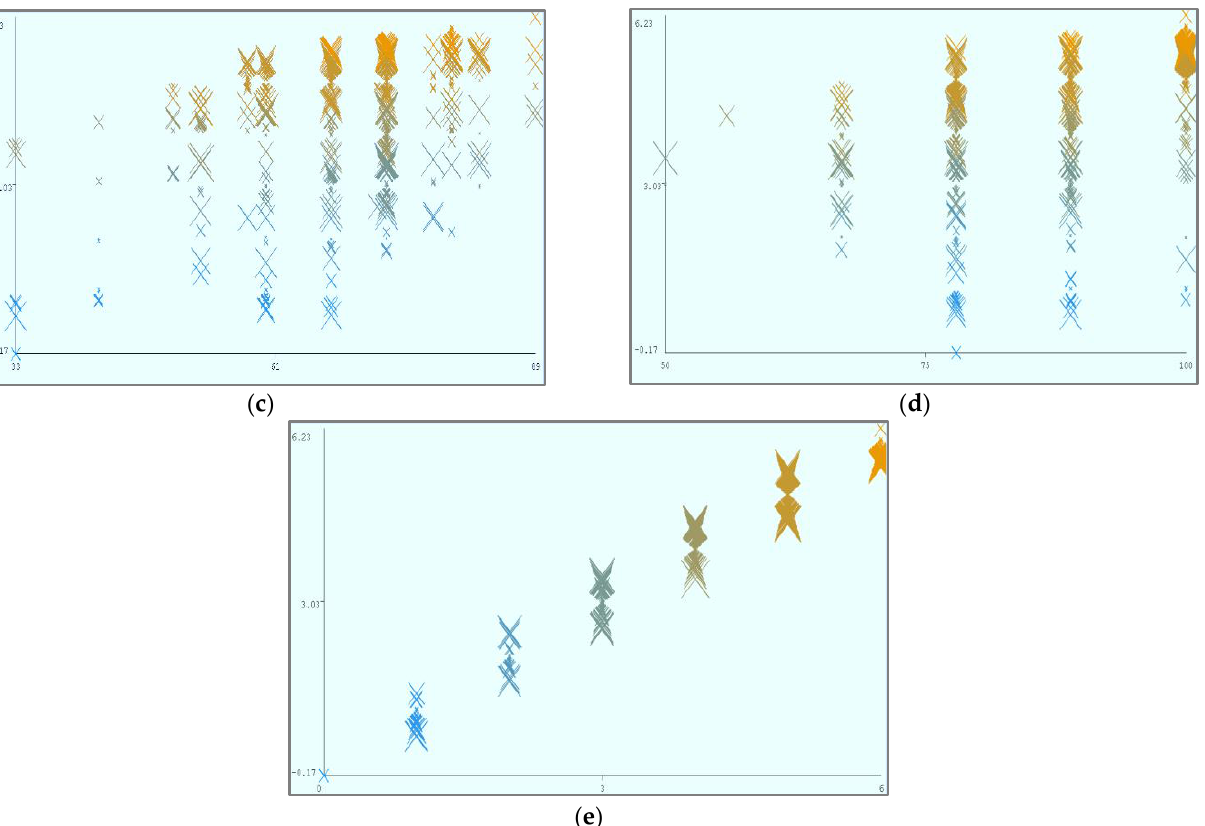
Figure 12. ( a ). Linear regression error (X: Availability vs. Y: Predicted Ranking). ( b ). Linear regression error (X: Security vs. Y: Predicted Ranking). ( c ). Linear regression error (X: Reliability vs. Y: Predicted Ranking). ( d ). Linear regression error (X: Cost vs. Y: Predicted Ranking). ( e ). Linear regression error (X: Ranking vs. Y: Predicted Ranking).